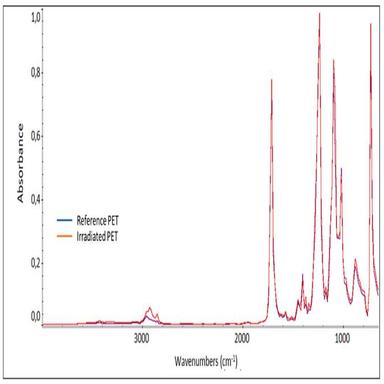
FTIR analysis: spectrum of the reference PET (blue trace) and of the 50% irradiated PET (red trace). (For interpretation of the references to colour in this figure legend, the reader is referred to the Web version of this article.)